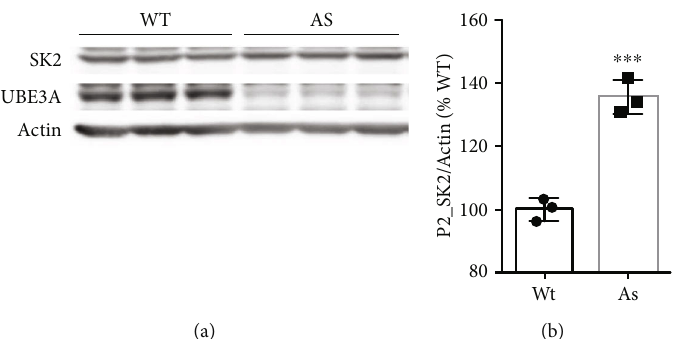
Figure 1: SK2 expression in hippocampus of female AS and WT mice. (a) Western blot analysis of SK2 levels in crude synaptosomal fractions (P2) fractions from hippocampus of female AS and WT mice. (b) Quantitative analysis of blots. Results are expressed as % of values in WT mice and shown as means ± SEM . N = 3 mice , ∗∗∗ P < 0 : 001 (unpaired, two-tailed Student ’ s